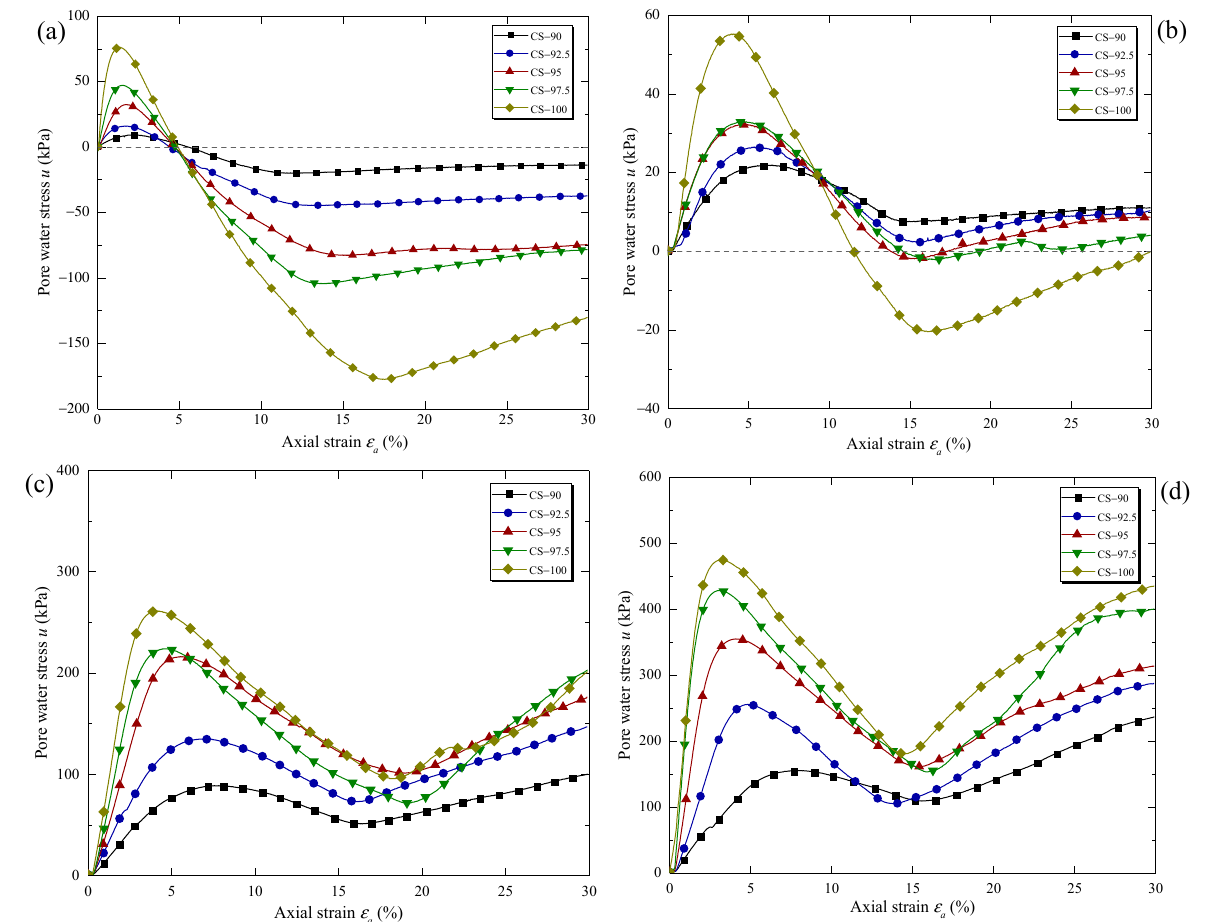
Figure 5. Pore water stress-axial strain curves of coral sand with different saturations: ( a ) σ 3’ = 200 kPa; ( b ) σ 3’ = 400 kPa; ( c ) σ 3’ = 600 kPa; ( d ) σ 3’ = 800 kPa. Within the σ 3’ range of 800 kPa, u − ε a curves of coral sand samples with 90–100% Sr during the UU triaxial shear stress state can also be separated into three stages: (1) In the initial shear stage, u rose rapidly with increasing ε a , and the sample con- tracted. In the initial UU triaxial shear stage, the sample’s pore water produced u under external loads. Growing ε a (or shear stress τ ) increased the mean effective stress ( p ’ ) borne by the sample, resulting in sample contraction. Sample contraction also enhanced the squeezing action on pore water and caused u to present a growing trend with rising ε a [41]. The peak pore water stress ( u p 1 ) can be utilized to characterize the maximum contraction degree of coral sand samples. The curve of u p 1 changing with Sr was plotted to explore the effect of Sr on u of a coral sand sample in the initial shear stage (Figure 6). According to Figure 6: (I) there is an apparent positive correlation between u p 1 and Sr under the same σ (cid:48) . A sample with a higher Sr level contains more pore water content and also produces a 3 more significant u under the constraint of σ (cid:48) . A positive correlation between u p 1 and Sr 3 indicates that a sample with a higher Sr level has a greater contraction degree in the initial shear stage. (II) For coral sand samples with the same Sr , u p 1 increases more significantly under high effective confining pressures ( σ (cid:48) = 600 and 800 kPa) than under low effective 3 ≤ 400 kPa), and the increments also increase with increasing Sr . This confining pressures ( σ (cid:48) 3 phenomenon was mainly caused by the constraint imposed by σ (cid:48) on coral sand samples. 3 ≤ 400 kPa), the constraining force was weak, Under a low effective confining pressure ( σ (cid:48) 3 and u was low and insensitive to the change in Sr . Increasing σ (cid:48) enhanced the constraining 3 force, caused the increase of u , and amplified the effect of Sr on u